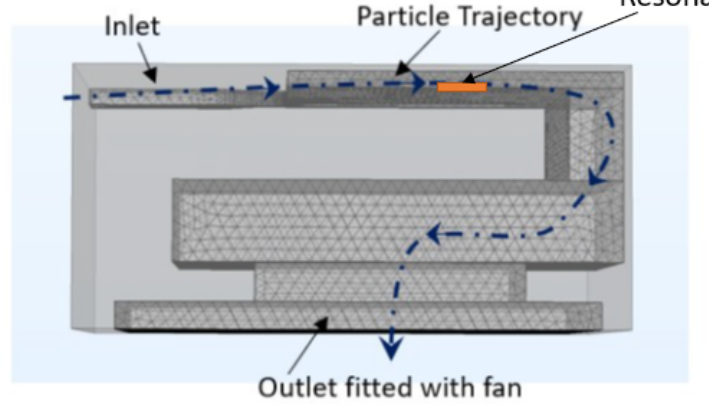
Figure 5. Trajectory of a particle from the inlet to the exit.